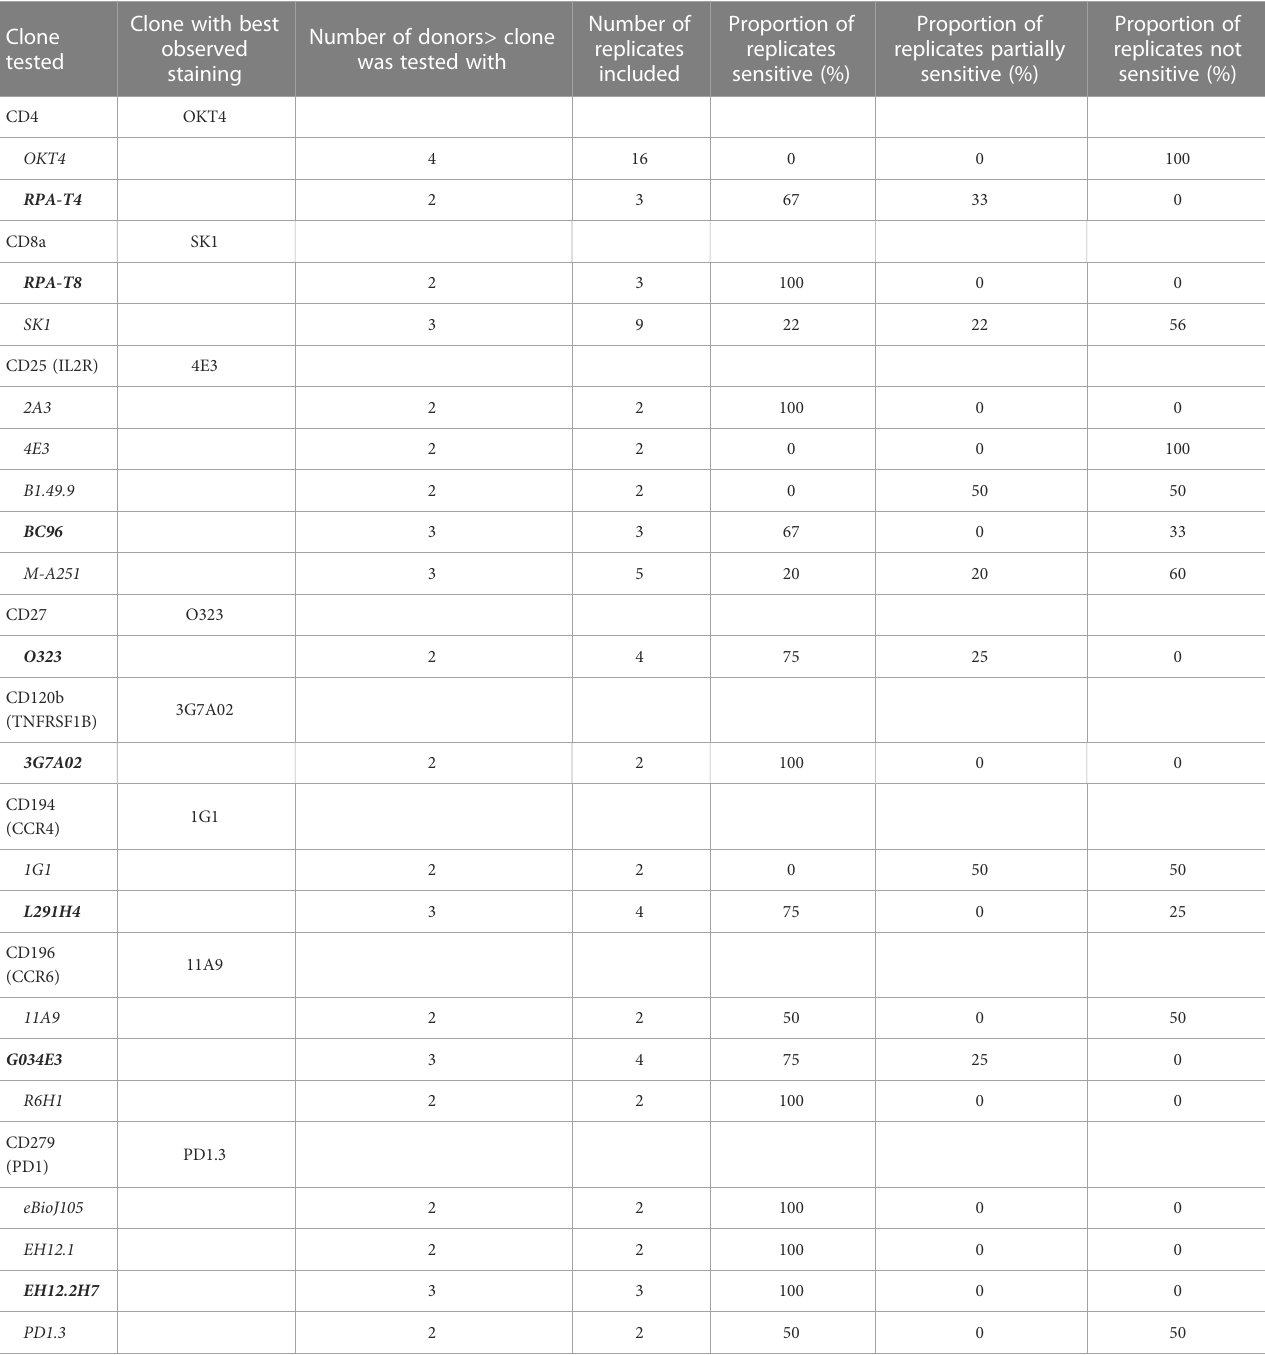
TotalSeq-C clones highlighted in bold